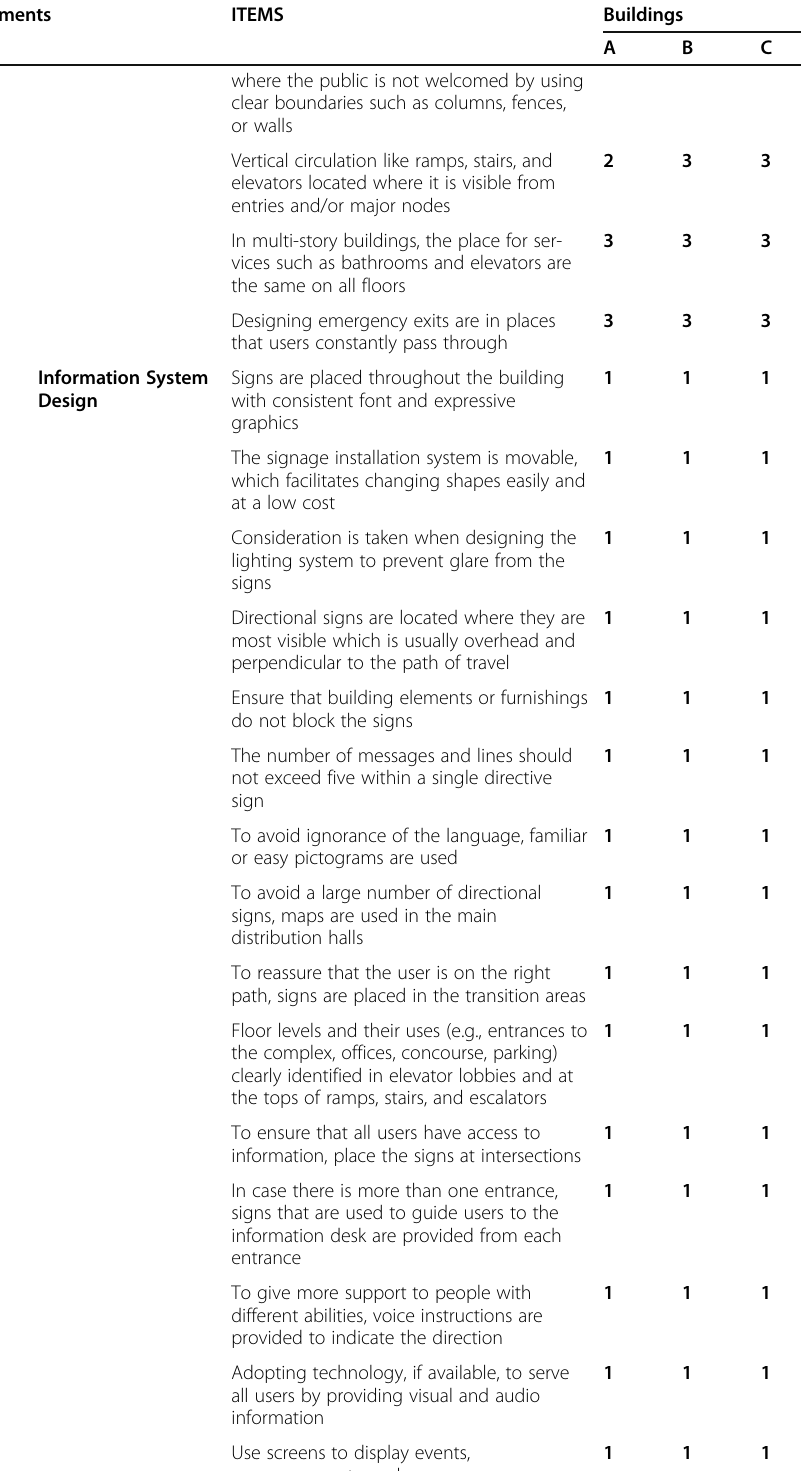
Table 3 The score of compliance to UD for each element and item in the three buildings (Continued) Main